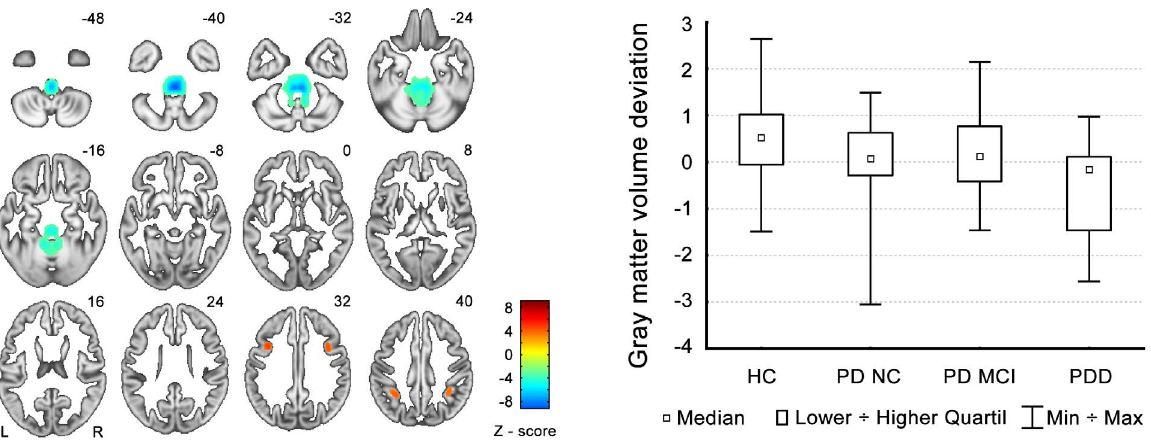
Figure 2. C2 component pattern and GMV changes in individual groups. The graph shows the deviations from the all-participants’ mean. GMV decreases are depicted by red color and GMV increases are in green. The box graph on the right side shows median GMV changes in individual groups of subjects.